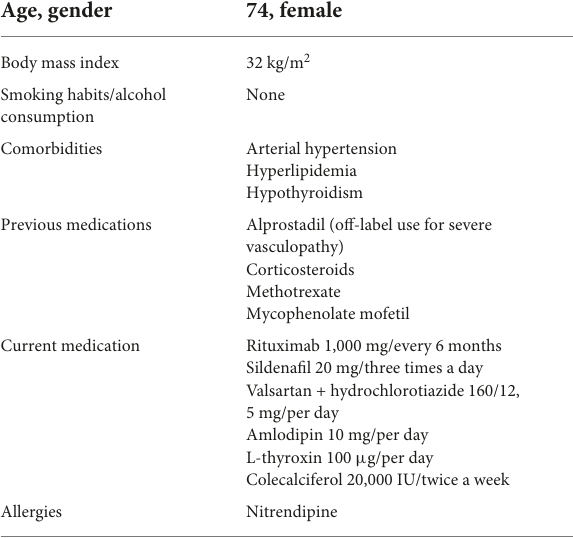
TABLE 1 Demographic and clinical data of the patient.